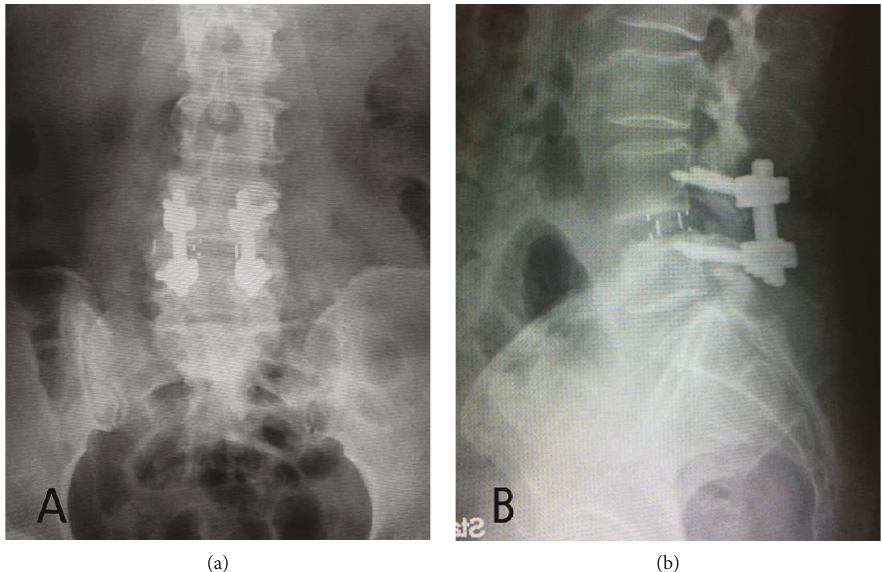
Figure 2: Postoperative plain fi lms of lumbar spine AP and lateral (a and b) showed the MIS-OLIF PEEK cage was placed too deep over edge of right lateral of vertebral body.